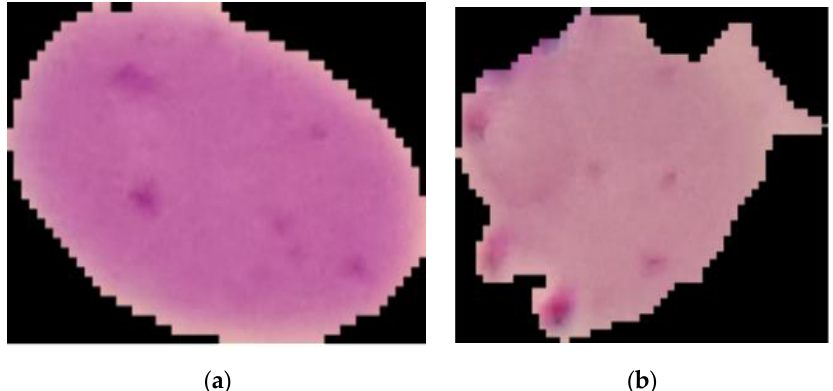
Figure 3. Normal red blood cells ( a ) and red blood cells infected with malaria ( b ).